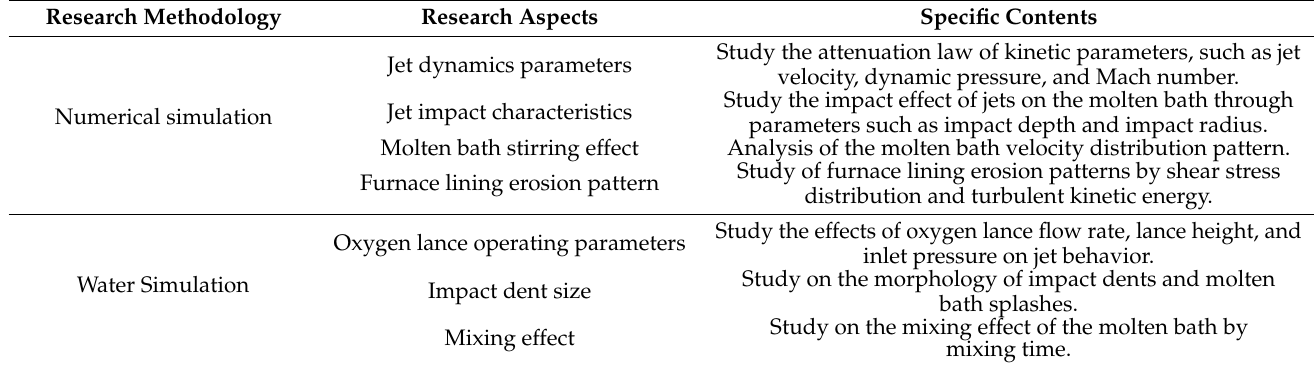
Table 2. The method and content of the study of oxygen lance jet